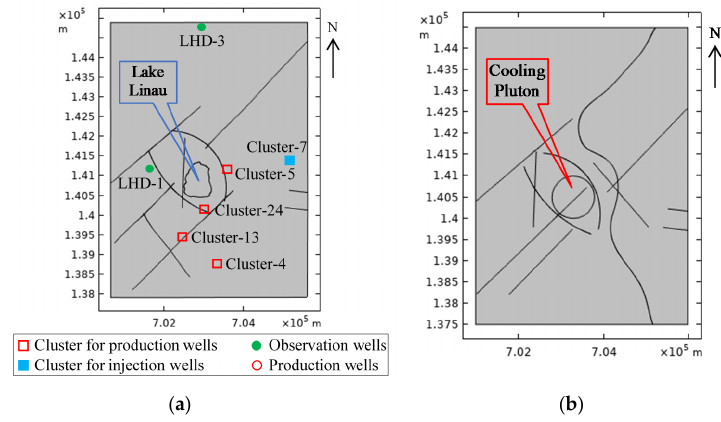
Figure 12. 3D model geometry.